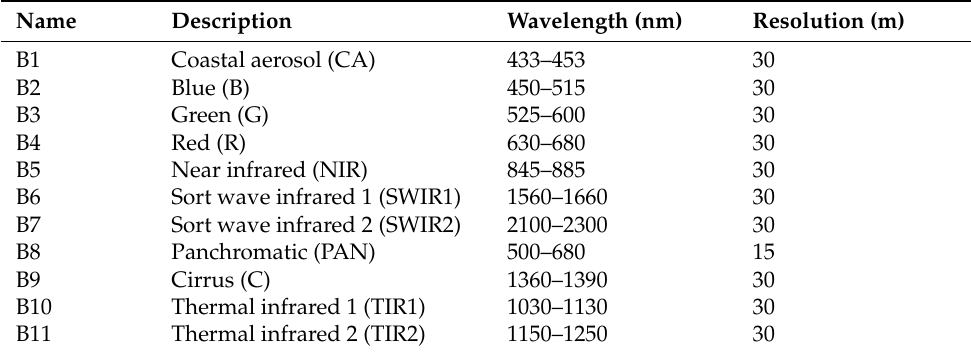
Table 1. Spectral band properties of Landsat-8 OLI